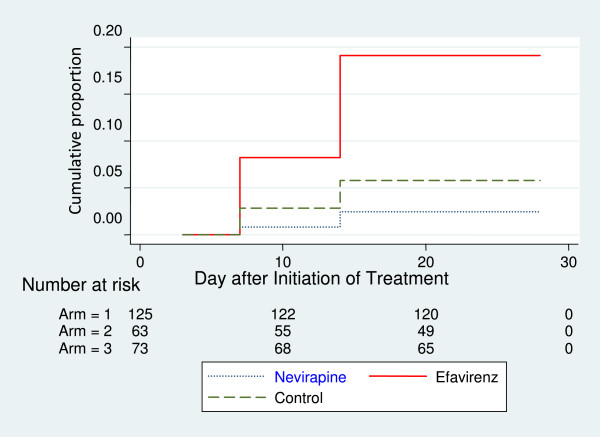
Kaplan Meier curve showing cumulative risk of treatment failure in HIV-1 infected patients treated with artemether-lumefantrine.